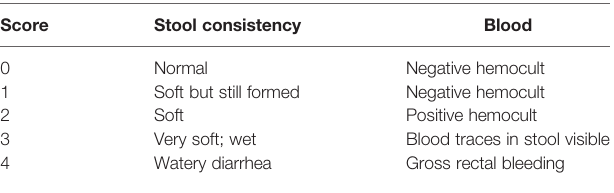
TABLE 2 | Scoring system for calculating a disease activity index based on stool consistency and the degree of intestinal